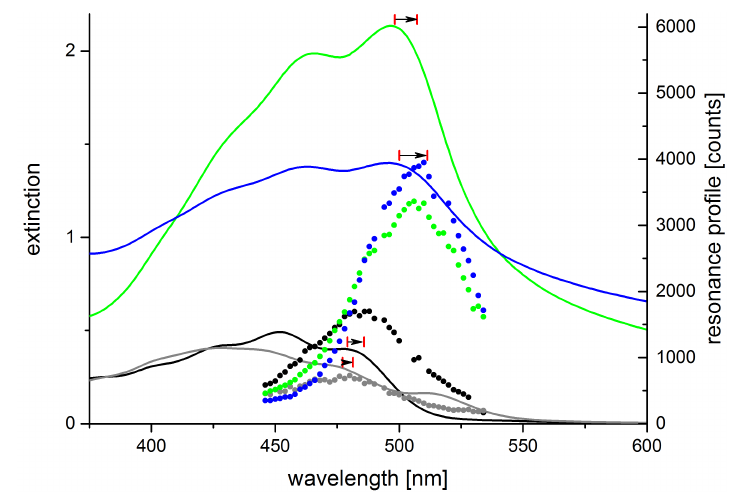
Figure 11. Absorption spectrum (solid lines) and resonance profiles of the strongest carotenoid Raman peak at ca. 1528 cm − 1 (C=C stretch) (dots) for β -carotene in different molecular environments. From top to bottom, the curves show resonance maps for 64 mg Altratene EM5% emulsion in 100 mL of water (green), a hydrogel stained with 11 mg Altratene EM5% emulsion in 100 mL of aqueous solution containing <12% ethanol (blue), and ethanol solutions with 20% (black) or 40% (gray) water content. Distance marks (arrows) at each 0-0 transition peak indicate the spectral shift between absorption and resonance maximum (reproduced with permission from (reproduced with permission from